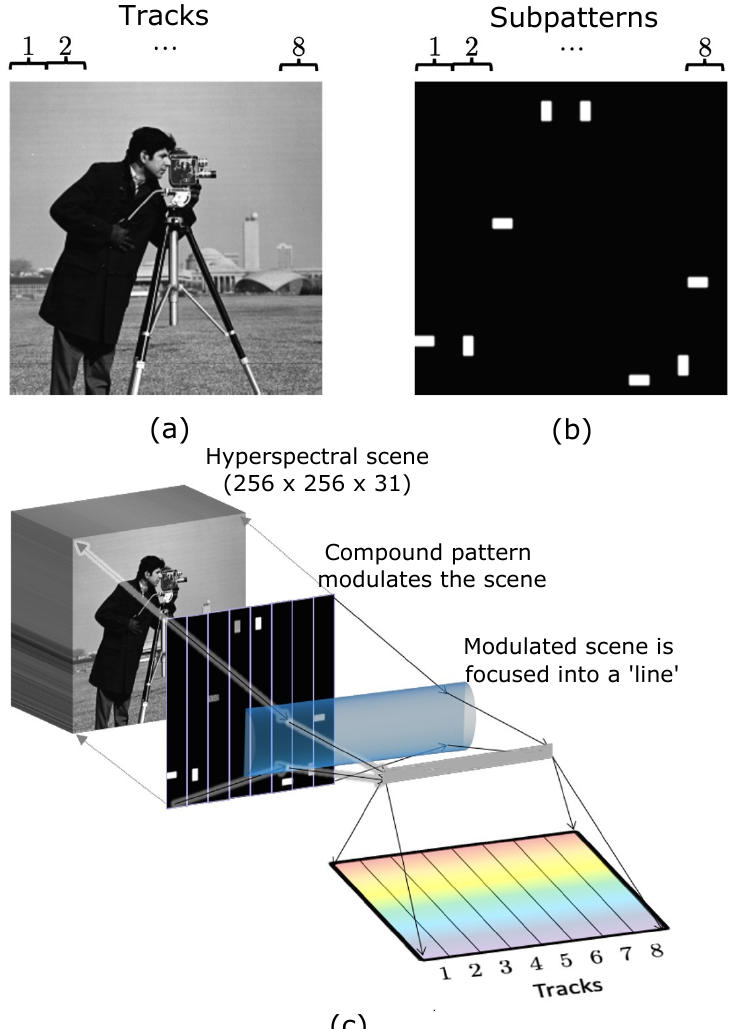
Figure 1. ( a ) Dividing a hyperspectral scene into tracks (8 tracks as an example) seen here as the dashed vertical strips. ( b ) A full compound pattern as formed by subpatterns (8 subpatterns in this example), again seen as the dashed vertical strips. ( c ) A schematic of the multitrack acquisition process. In every shot, the hyperspectral scene is modulated by a compound pattern, focused into a line and dispersed in a spectrometer. The 2D detector array records one spectrum from each